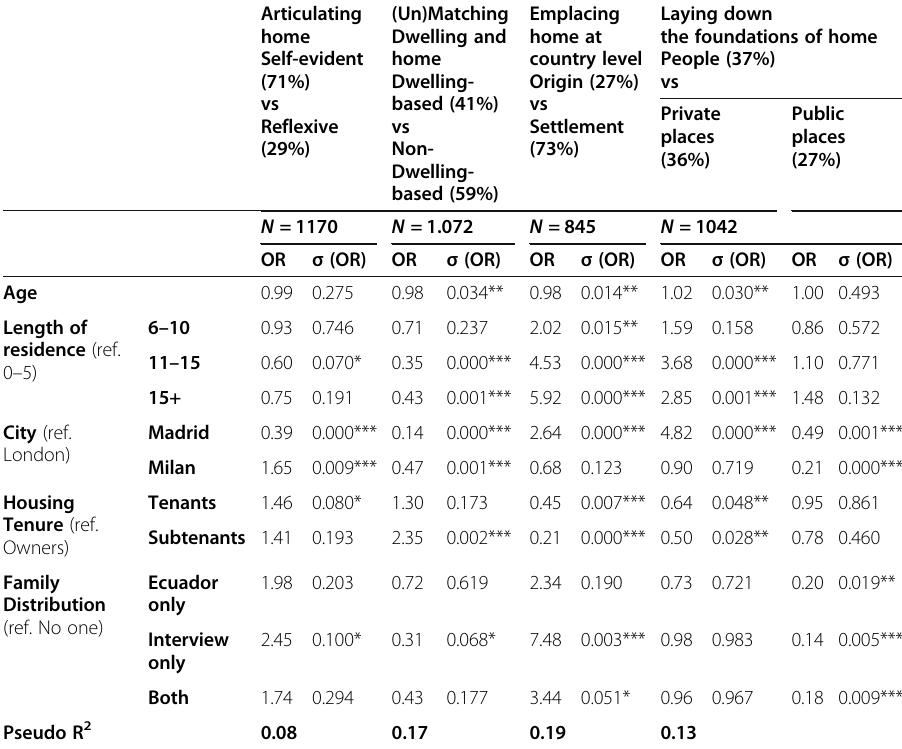
Table 2 Logistic regression models for the dependent variables by age, length of residence, city, housing tenure and family